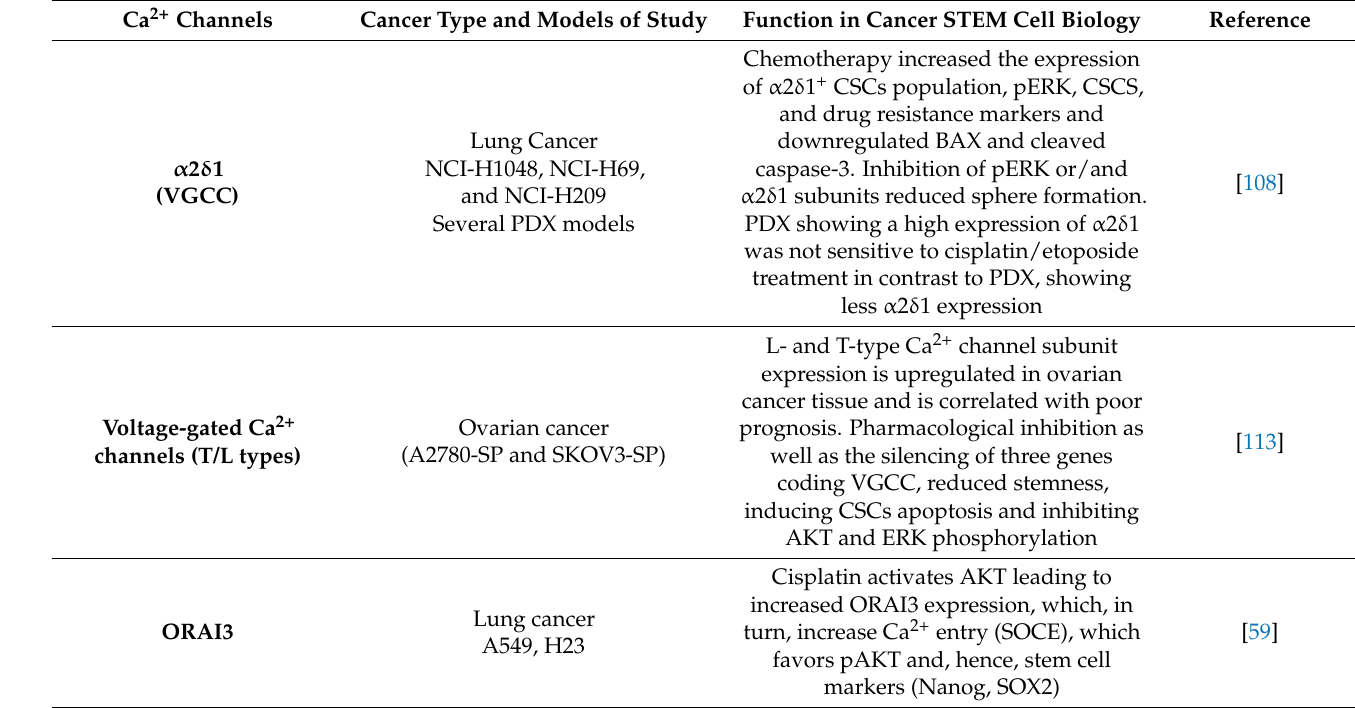
Table 3. Ca 2+ signaling is responsible for cisplatin resistance through